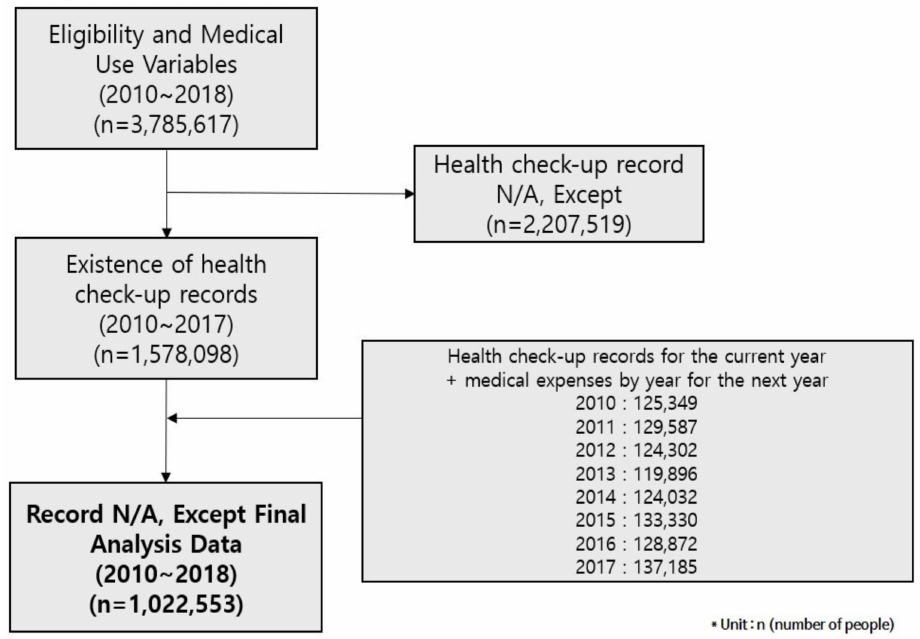
Figure 1. Generating data from the Korea National Health Insurance Corporation cohort